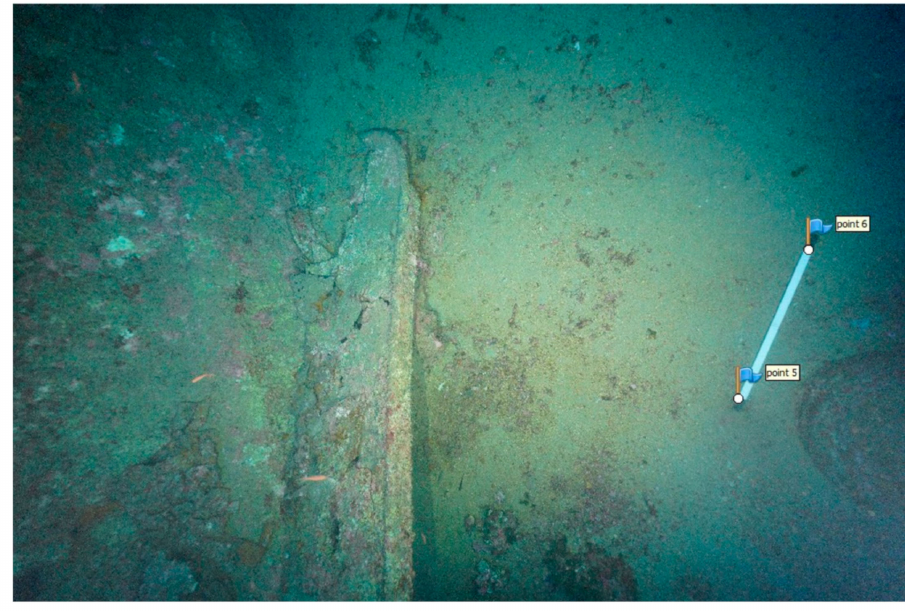
Figure 6. Example of a scale bar.